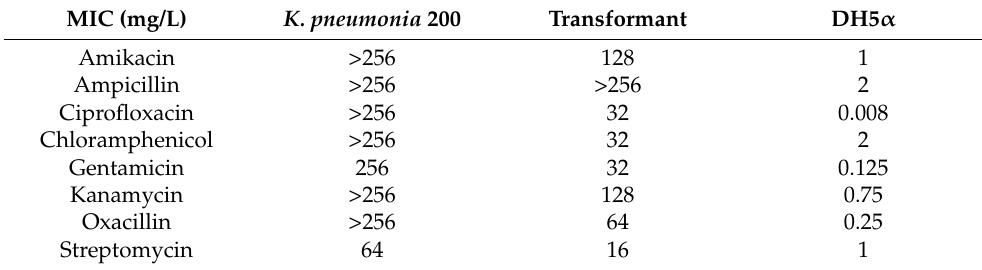
Table 1. MICs * of K. pneumonia and